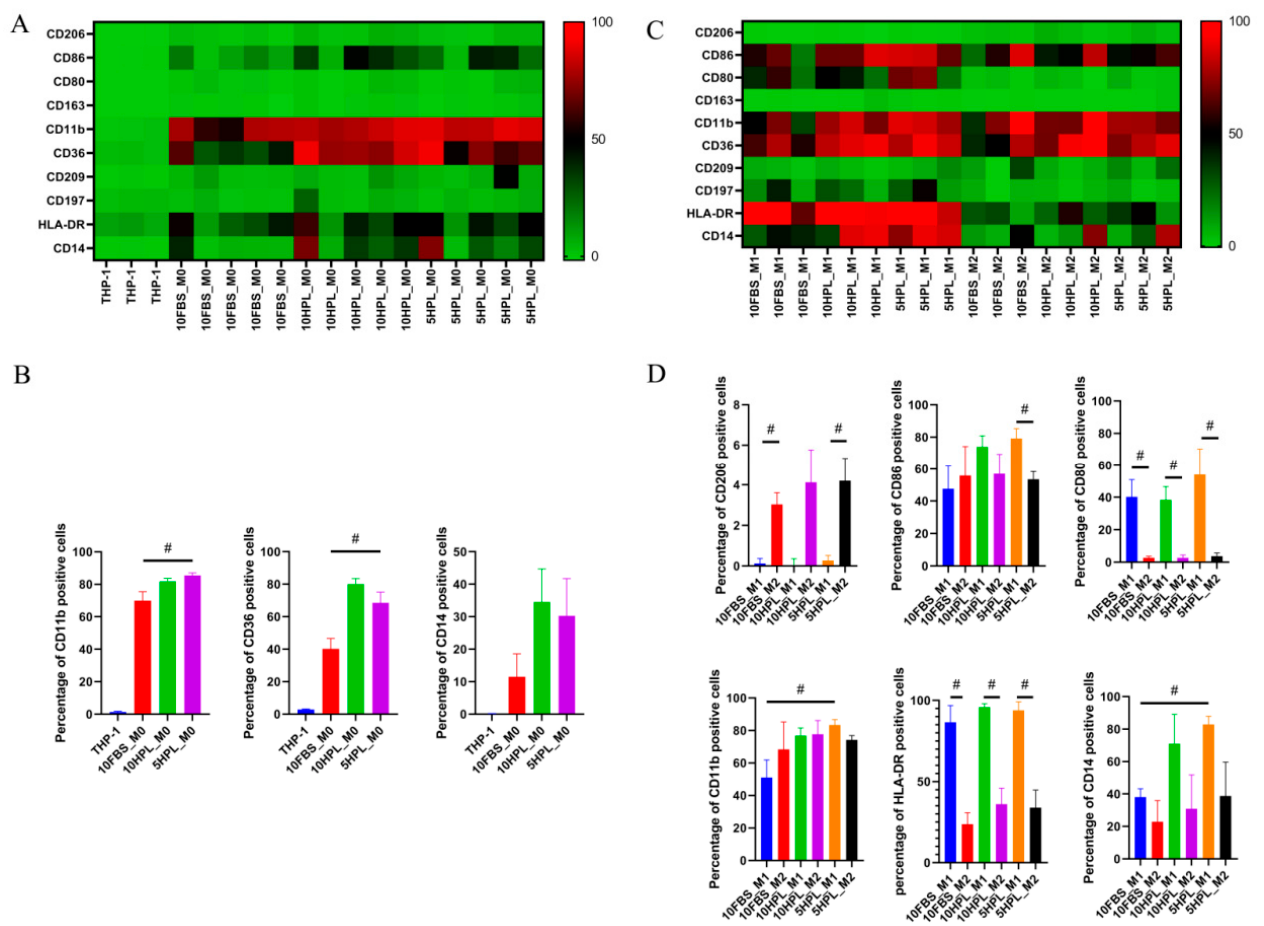
Figure 3. Analysis of surface marker expression of undifferentiated THP-1 cells and induced M0, M1, and M2 macrophages under FBS or hPL supplementation by flow cytometry. ( A ) Heat map of THP-1 cells and M0 macrophages’ surface marker expression. ( B ) Surface expression of CD11b, CD36, and CD14 in THP-1 and M0 macrophages ( n = 3–5, # p < 0.05). ( C ) Heat map of M1 and M2 macrophage surface marker expression. ( D ) Surface expression of CD206, CD86, CD80, CD11b, HLA-DR, and CD14 in M1 and M2 macrophages ( n = 3, # p < 0.05).